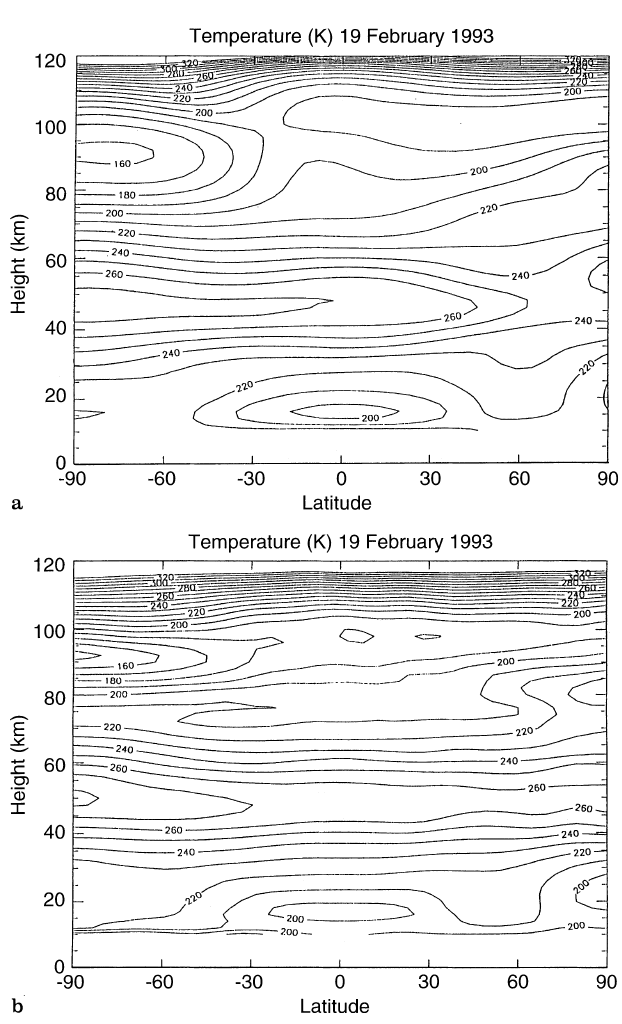
Fig. 2a,b. Zonally averaged temperature at solar minimum for 19th February, 1993 a from the MSIS-90E model atmosphere, b from the extended Meteorological O(cid:129)ce stratosphere mesosphere model for the same date integrated from December 1st